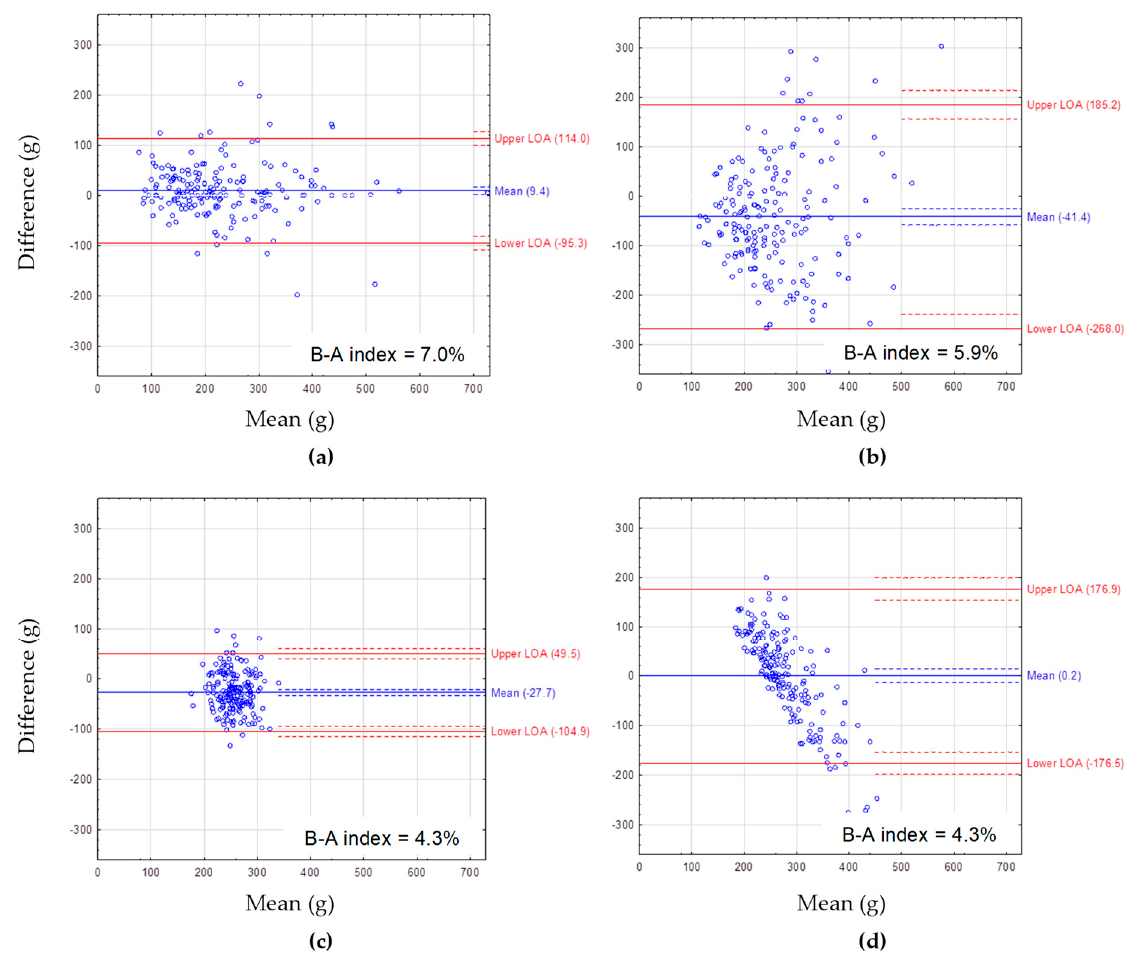
Figure 3. The Bland–Altman plots for carbohydrate intake assessed with: ( a ) FFQcrude and FFQretest, ( b ) FFQcrude and FRcrude, ( c ) FFQstand and FRstand, ( d ) FFQreg and FRcrude. FFQcrude—crude data from the first administration of the FFQ (test), FFQretest—crude data from the second administration of the FFQ, FRcrude—crude data from the 2-day estimated food record (FR), FRstand—the FR data after standardization of energy intake, FFQstand—the FFQ data after standardization of energy intake, FFQreg—the FFQ data adjusted by regression. Mean—mean difference in carbohydrate intake between the methods (blue solid line) with 95% CI (dashed lines). LOA—95% limits of agreement between the methods (red solid lines) with 95% CI (dashed lines). B-A index—the Bland–Altman index calculated as percentage of respondents beyond LOA.